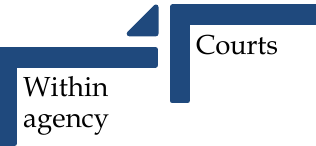
Figure 6: Levels of RTI Appeals in South